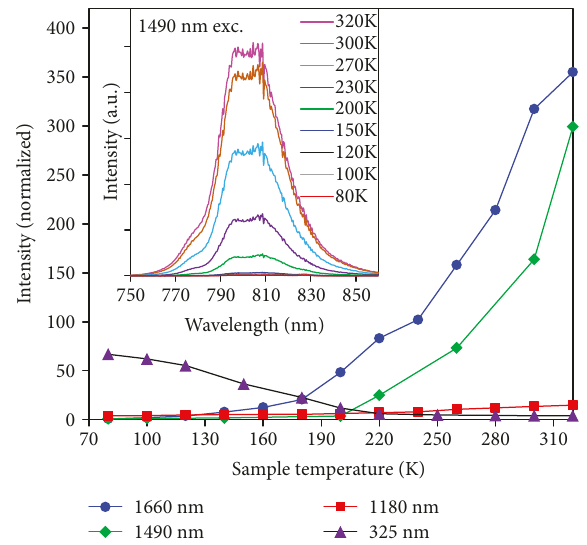
Figure 3: Relationship between the sample temperature and UC emission intensities (centered at 800 nm) for the CaTi sample excited at di ff erent wavelengths. Stokes emission intensity while excited at 325nm is also plotted for comparison. The inset is the typical spectra while excited at 1490